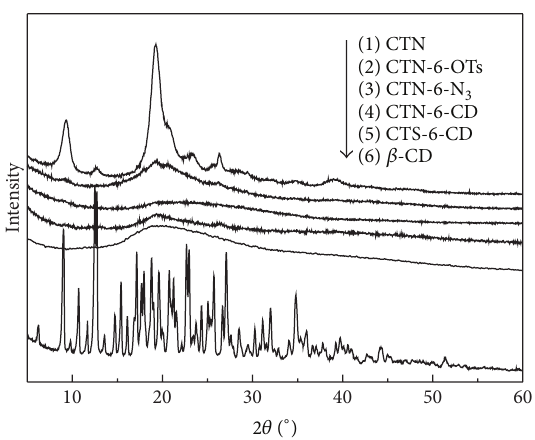
Figure 2: FTIR spectrums of the synthesized products in the reactions.